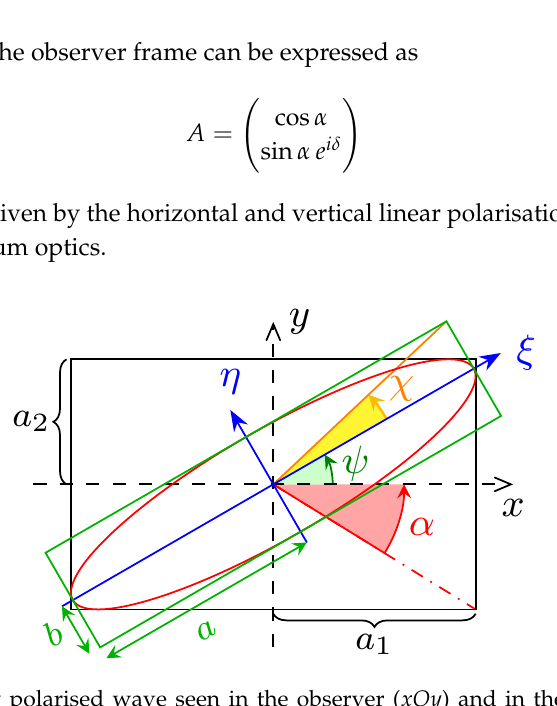
Figure 13. Elliptically polarised wave seen in the observer ( xOy ) and in the ellipse ( ξ O η ) frame. The vibrational ellipse is for the electric field. The semi-major axis ξ is tilted from x by the angle ψ . The semi- axes length are a and b , not to be confused with the amplitudes a 1 and a 2 of the oscillations expressed in xOy